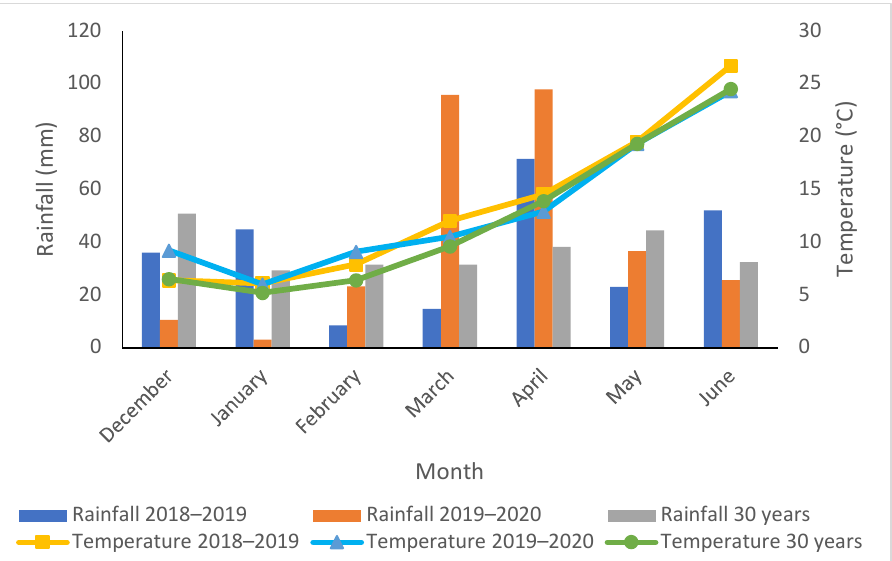
Figure 1. Main weather parameters (mean temperature and rainfall) for the two growing seasons (2018–2019 and 2019–2020) of experimentation at Thermi, Greece, and its comparison to the 30-year average. The weather data were recorded using an automatic weather station close to the site.